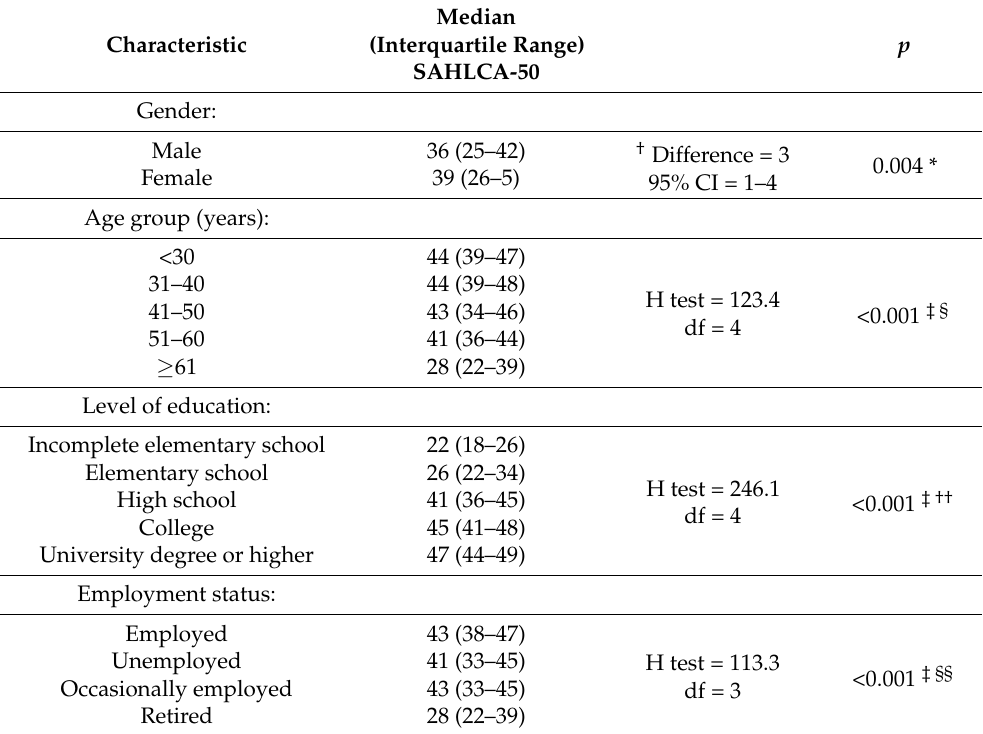
Table 3. Differences in SAHLCA-50 score according to patient characteristics ( n =